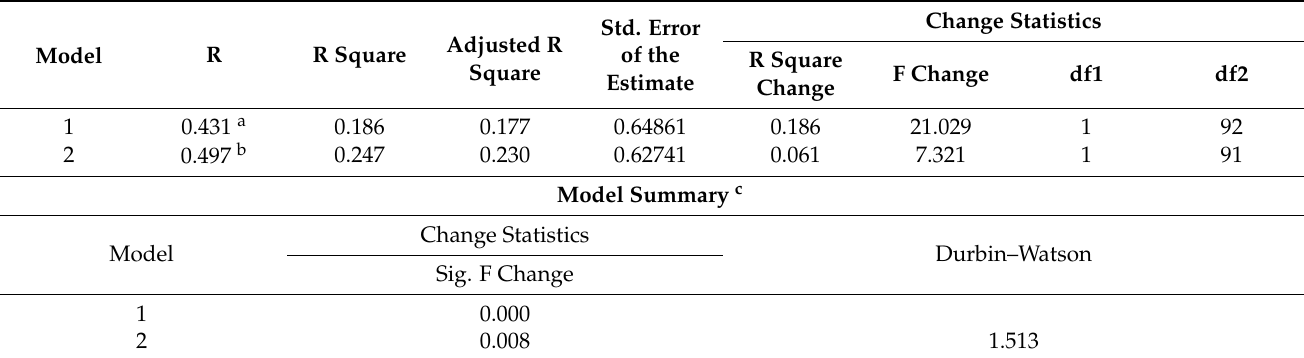
Table 4. Predictive model of involvement practices and authoritarian style.